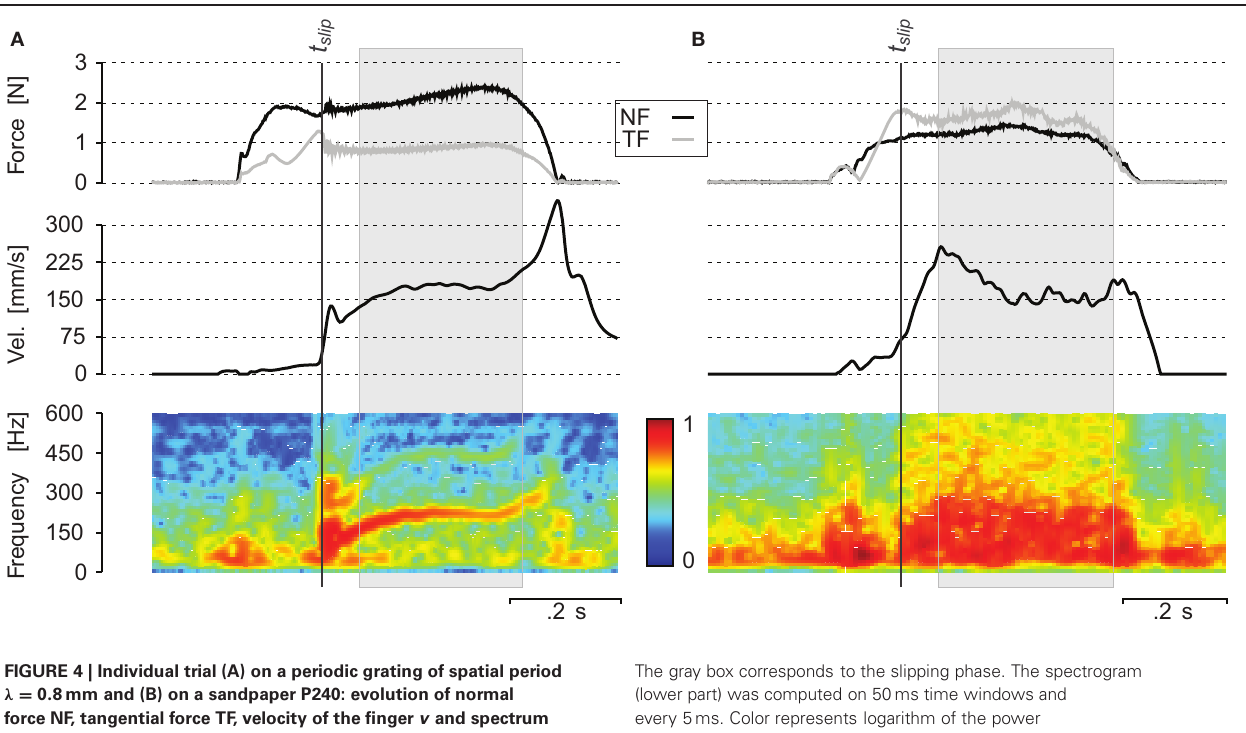
The gray box corresponds to the slipping phase. The spectrogram (lower part) was computed on 50ms time windows and every 5ms. Color represents logarithm of the power spectrum.